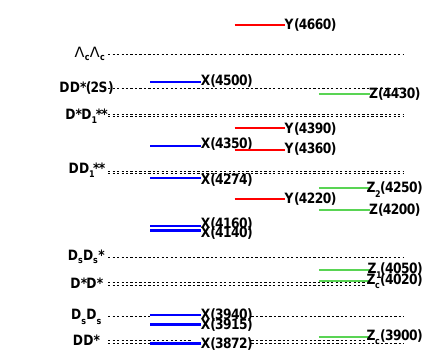
Figure 3. The above open-charm-threshold charmonium & charmoniumlike spectrum in 2018.